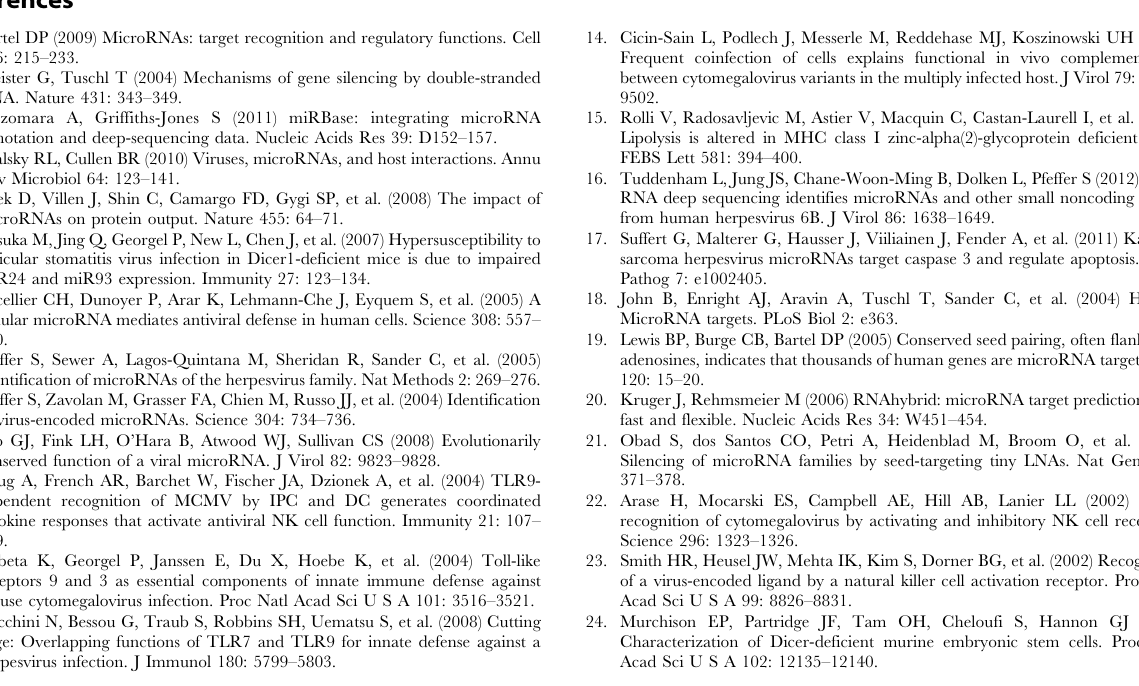
(TIF) Figure S3 Dicer d/d mutation impairs IFN-stimulated genes induction upon MCMV infection; statistical anal- ysis. A. Histogram showing relative expression of IFN-dependent genes (fold change between non-infected vs . MCMV-stimulated) in macrophages from controls (black bars) and Dicer d/d (white bars) mice 24 hours p.i. B. Similar analysis performed 72 hours p.i. C. Similar analysis performed in splenocytes 3 days upon in vivo MCMV infection of mice. (TIF) Figure S4 miRNAs expression is strongly reduced in MCMV-infected macrophages harvested from Dicer d/d mice. A. Pie chart representing the proportion of overexpressed (green), repressed (blue) and unaffected miRNAs involved in immunity/inflammation in MCMV-stimulated control ( + / + ) macrophages and Dicer d/d mutants. B. Histogram showing relative expression (Fold change between naı¨ve and MCMV-infected) of miRNAs in control ( + / + , dark bar) and Dicer d/d (light grey bar) macrophages.